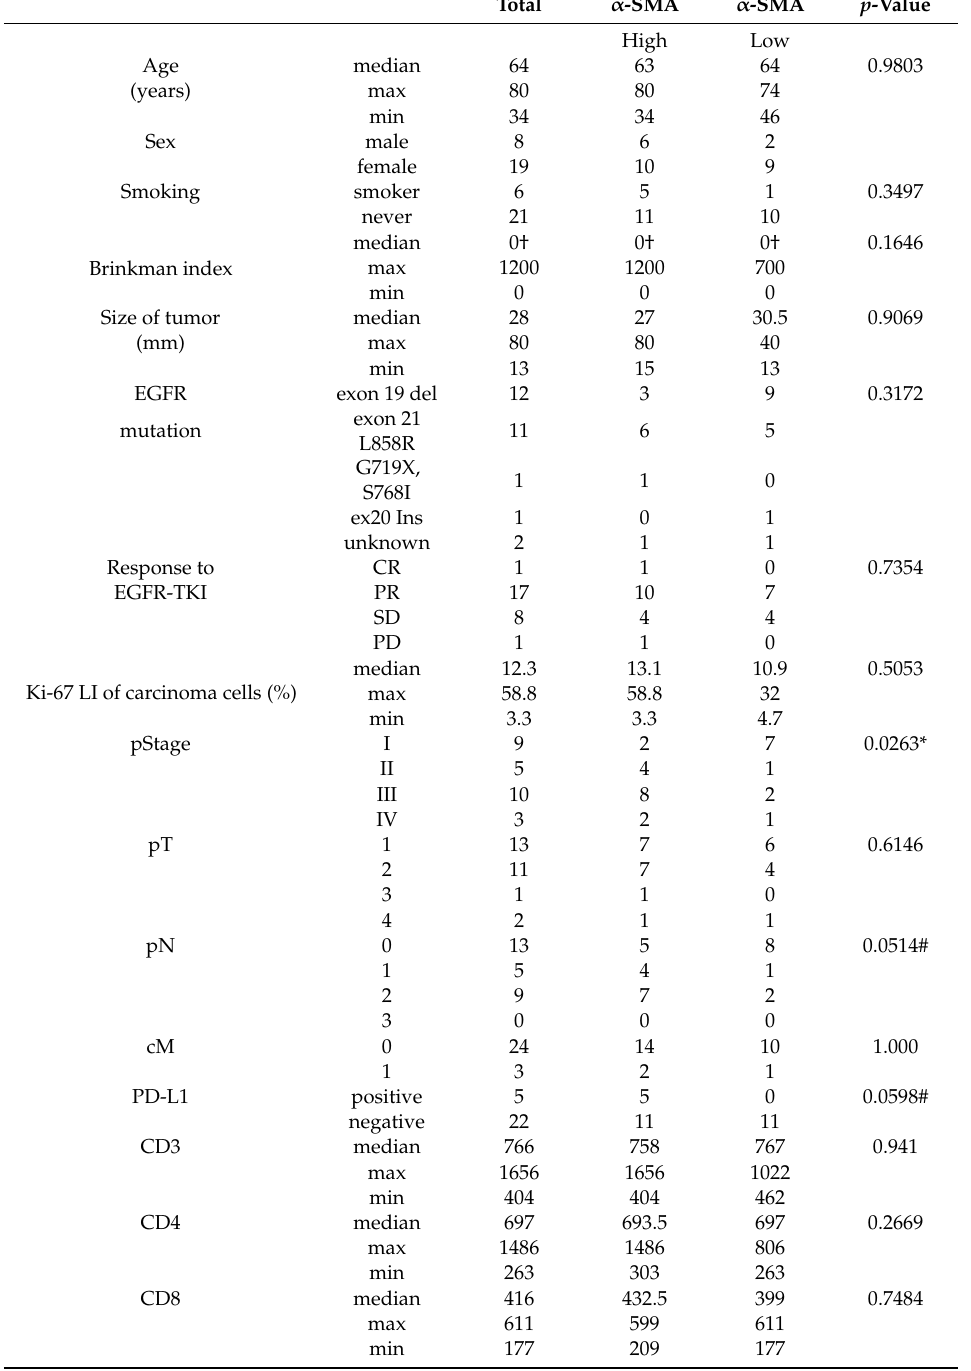
Table 1. Association between α -SMA status and clinicopathological parameters in lung adenocarcinoma cases (Cohort